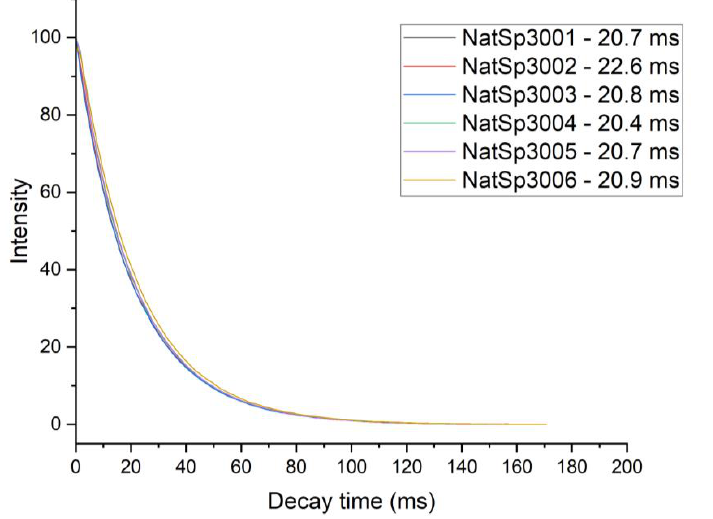
Figure 4. Six photoluminescence decay curves at 685 nm of the rough spinel NatSp3.